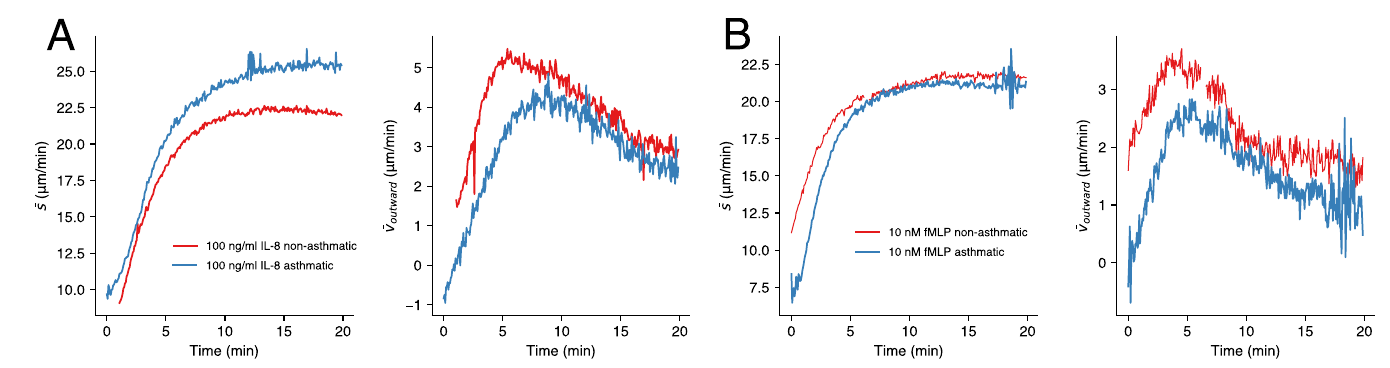
Fig 7. Reduced migration speed of neutrophils from asthma patients towards chemotactic gradients of (A) IL-8 and (B) fMLP. While the undirected cell speed can be elevated in asthma patients (IL-8, left graph), the directed outward movements is slower at any time and for both chemoattractants, IL-8 and fMLP. Each graph in every figure displays the weighted average of three independent